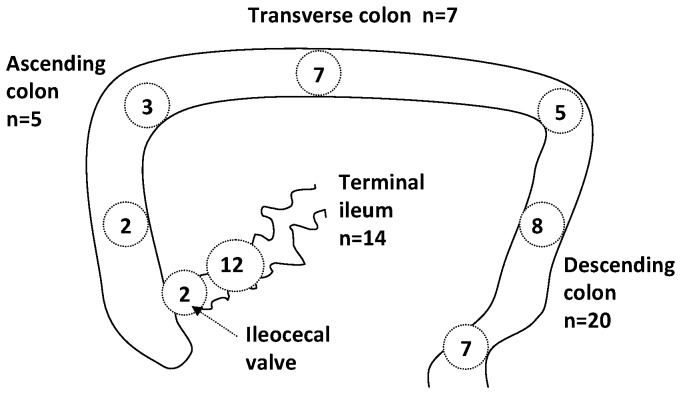
Localization of post-NEC strictures.